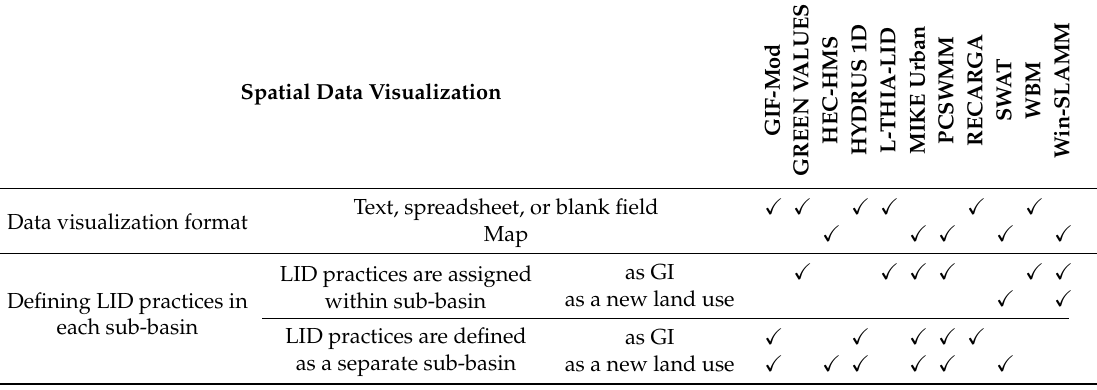
Table 6. Comparing spatial data visualization format and approach of placing GI in the catchment.